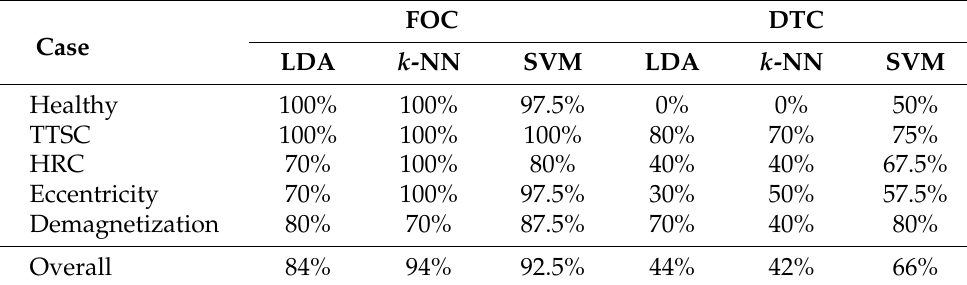
Table 6. Detection accuracy using MVSA approach for FOC- and DTC-driven PMSM.